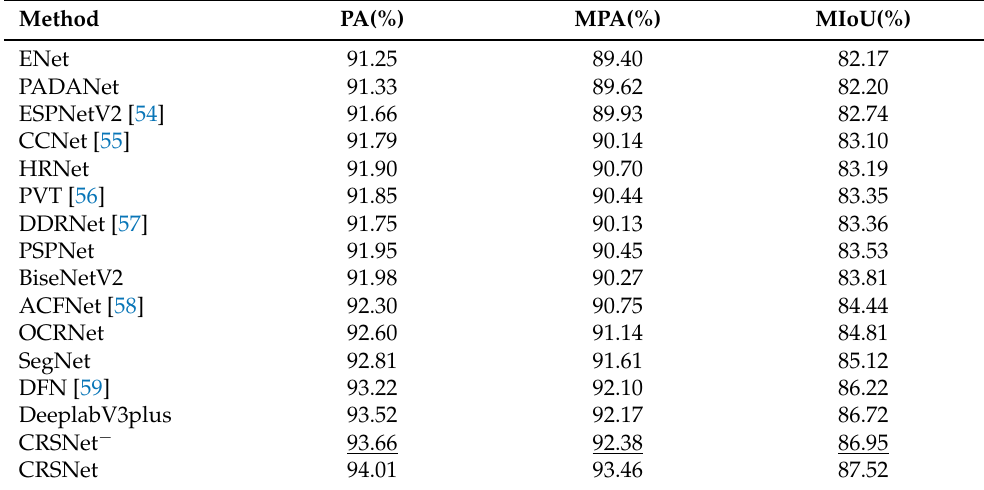
Table 4. Comparison of evaluation metrics of different models on CSWV Dataset. Symbol “_” indicates no